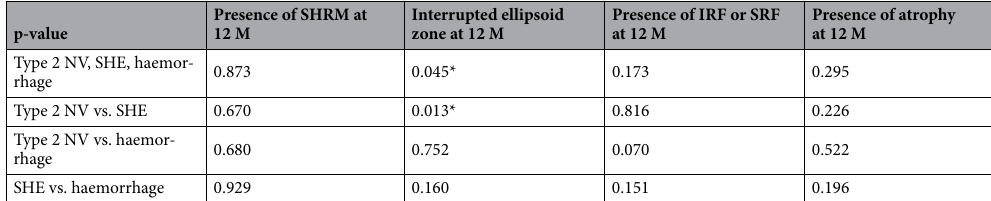
Table 4. OCT morphological features in different SHRM groups. *Compared with baseline: p < 0.05. OCT optical coherence tomography, NV neovascularization, SHE subretinal hyperreflective exudation, SHRM